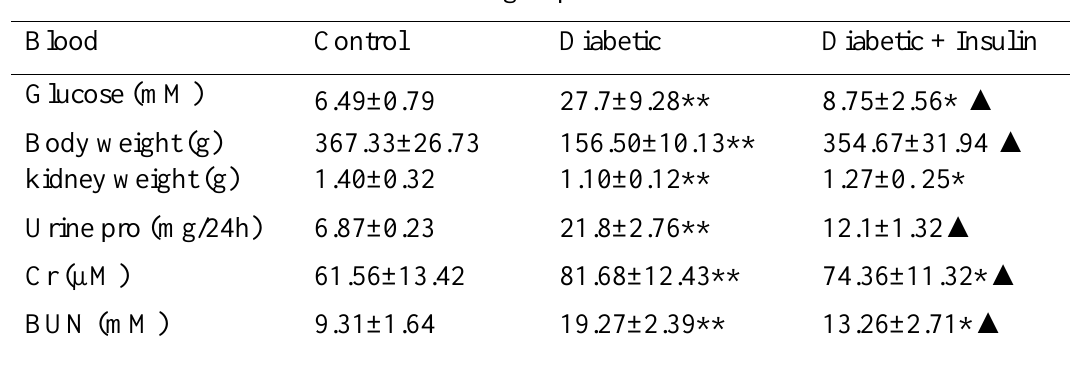
Table 1. The effects of streptozotocin-diabetes and insulin treatment on the blood glucose, Body weight , Pro, Cr , BUN and Kidney weight levels in the rats( mean ±